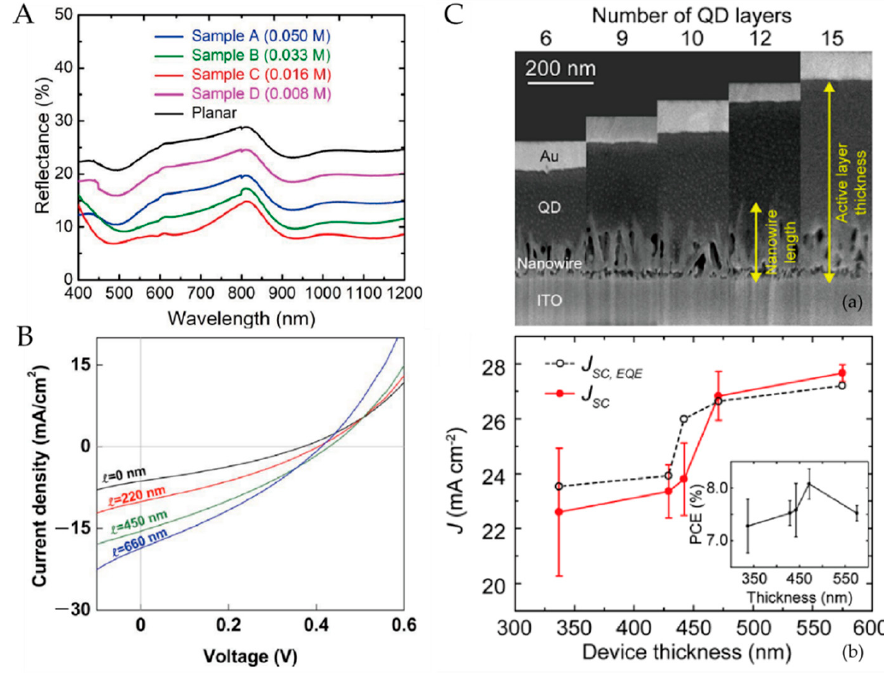
Figure 5. ( A ) Reflectance spectra of ZnO NWs with different areal densities grown on certain substrate [93]; ( B ) I ‐ V curves of CQDSCs assembled with different length NWs [83]; ( C ) ( a ) SEM images of NW CQDSCs with different NW lengths, ( b ) corresponding device performance of different CQD layers [91].